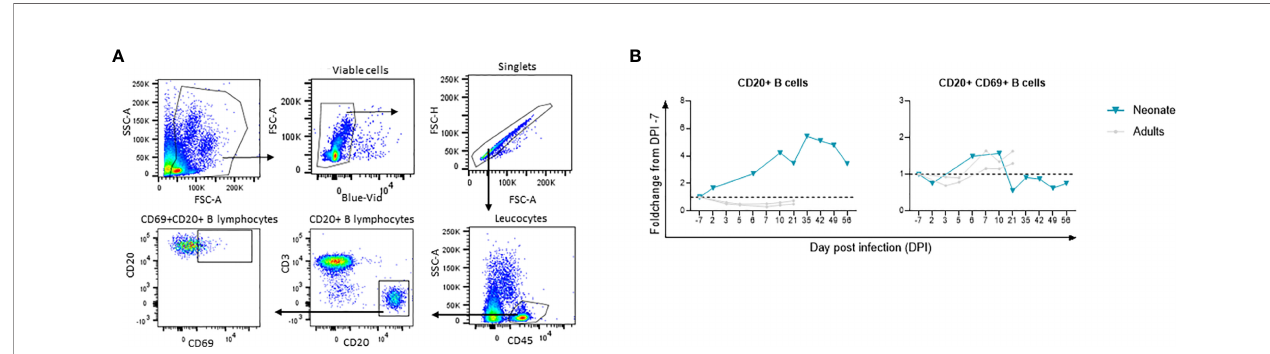
FIGURE 6 | Flow cytometry analyses for longitudinal B cell immune response following infection. Fold-changes from the baseline are shown for each cell population. The neonate is shown in blue line whereas adults (n=2) are shown in grey lines. (A) Gating strategy for B cell subsets. (B) CD45+CD20+B cells and activated CD69 + CD20 + B cell fold change from the baseline. The dashed line represents the baseline (Fold change